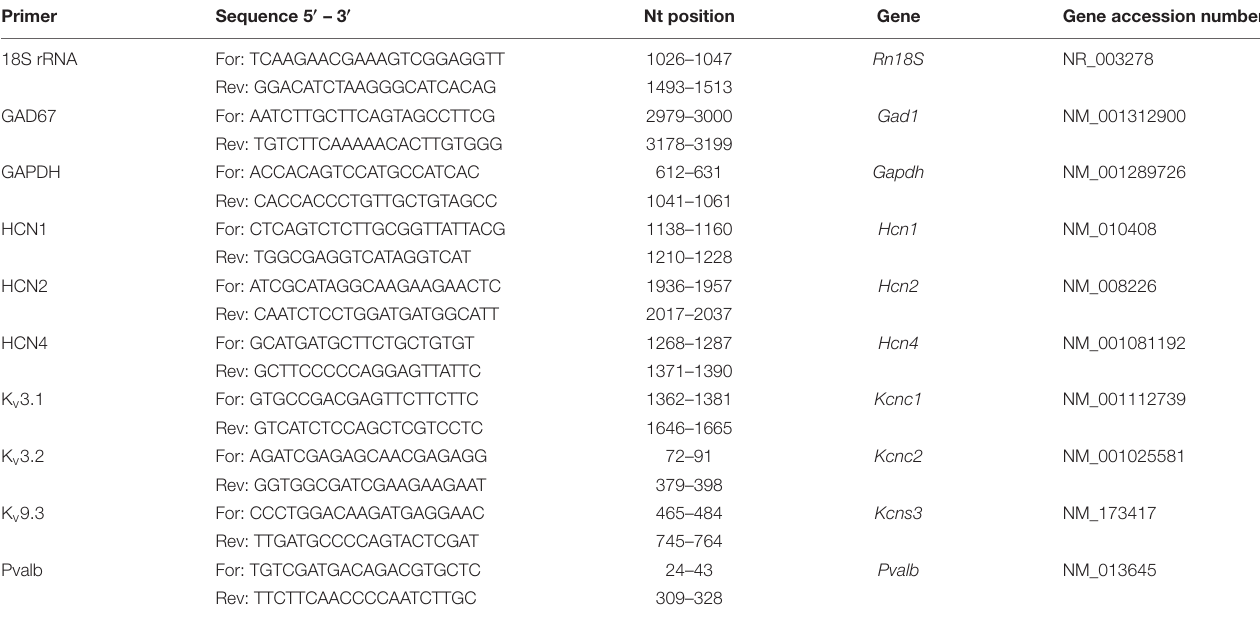
TABLE 3 | RT-qPCR